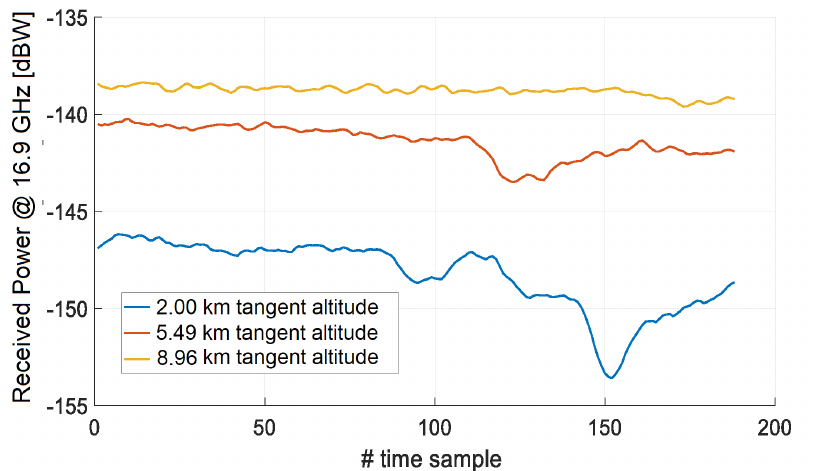
Figure 8. Time sequence of the received power at 16.9 GHz.